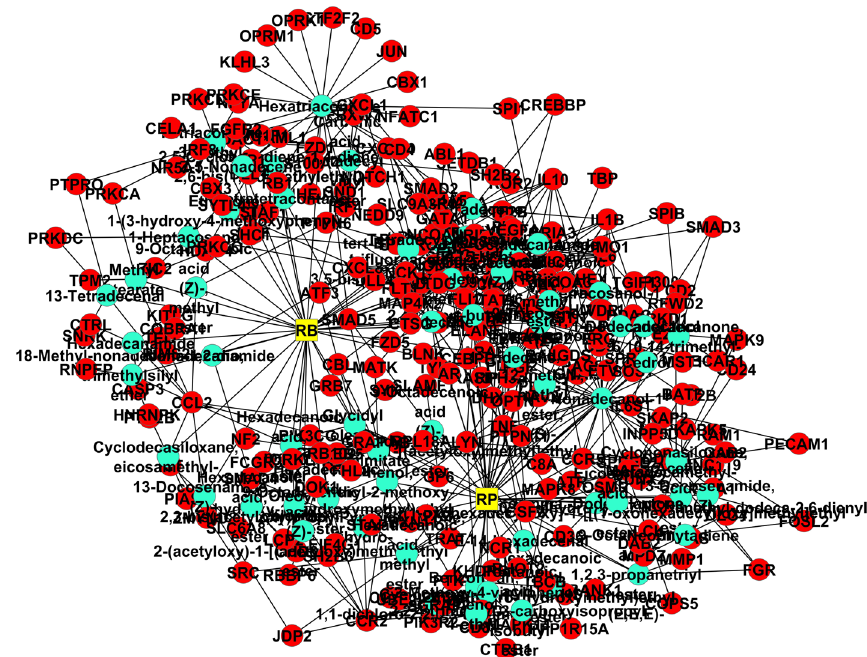
Fig. 3 Herb-compositive compound-putative target network. Edges: interactions between herbs, compounds and putative target; yellow square nodes: Ruellia prostrata (RP) and Ruellia bignoniiflora (RB) herbs; green round nodes: RP–RB compositive compounds; red round nodes: putative